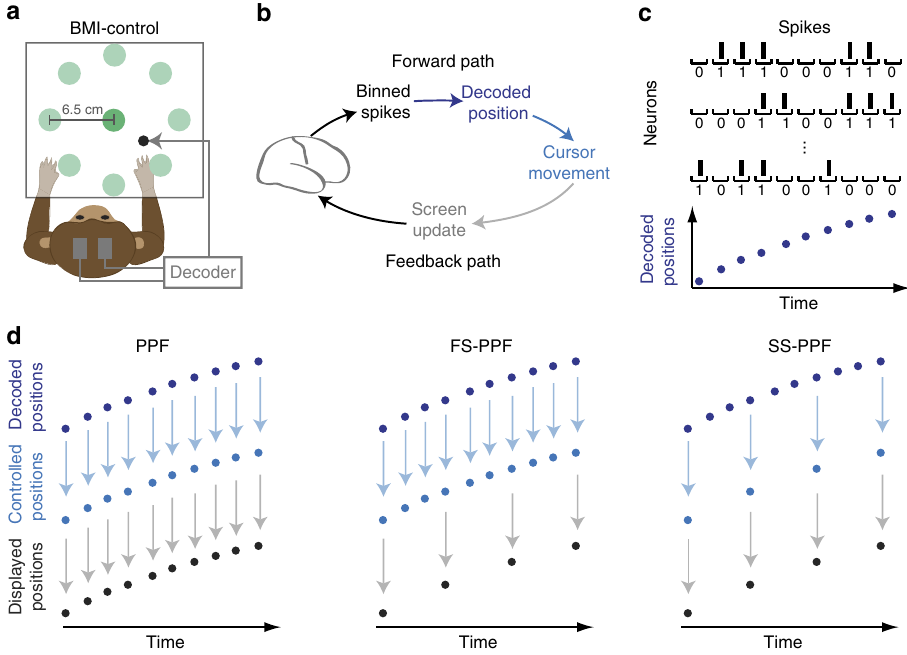
Figure 1 | Task design and experimental setup. ( a ) Monkey J performing the self-paced delayed centre-out movement task in brain control. The BMI paradigm introduces a novel bidirectional pathway between the brain and the prosthetic. ( b ) The BMI control and feedback loop, with all pathway processes illustrated. As further illustrated in d , control rate was manipulated by modifying the decoded position to cursor movement portion of the loop, while feedback rate was manipulated by adjusting the cursor movement to screen-update portion of the loop. ( c ) Each row corresponds to the spikes for a different hypothetical neuron. Spikes are binned in small intervals such that each interval contains at most one spike. This creates a discrete-time point process. PPF decodes the position with every 0 and 1. Example decoded positions in one dimension versus time are shown in dark blue and are updated with every 0 and 1. Hence any control and feedback rate below this high bin rate can be obtained. ( d ) The process of generating the controlled and feedback positions in PPF, FS-PPF and SS-PPF are shown for the same hypothetical spike train. Control rate is manipulated by adjusting how often the PPF’s decoded position is sent to the prosthetic and used to control the task (controlled positions in light blue). Task success is assessed based on these controlled positions. Feedback rate is adjusted by changing the rate at which feedback of the controlled positions is provided to the subject (displayed positions in black). PPF consists of both a fast control and a fast feedback rate, FS-PPF consists of a fast control and a slow feedback rate, and SS-PPF consists of a slow control and a slow feedback rate. For illustration purposes, the slow rate is selected as one-third of the maximal bin rate in this figure. Blue arrows show which decoded positions are sent to the prosthetic over the forward path, and grey arrows show which controlled positions are displayed to the monkey over the feedback